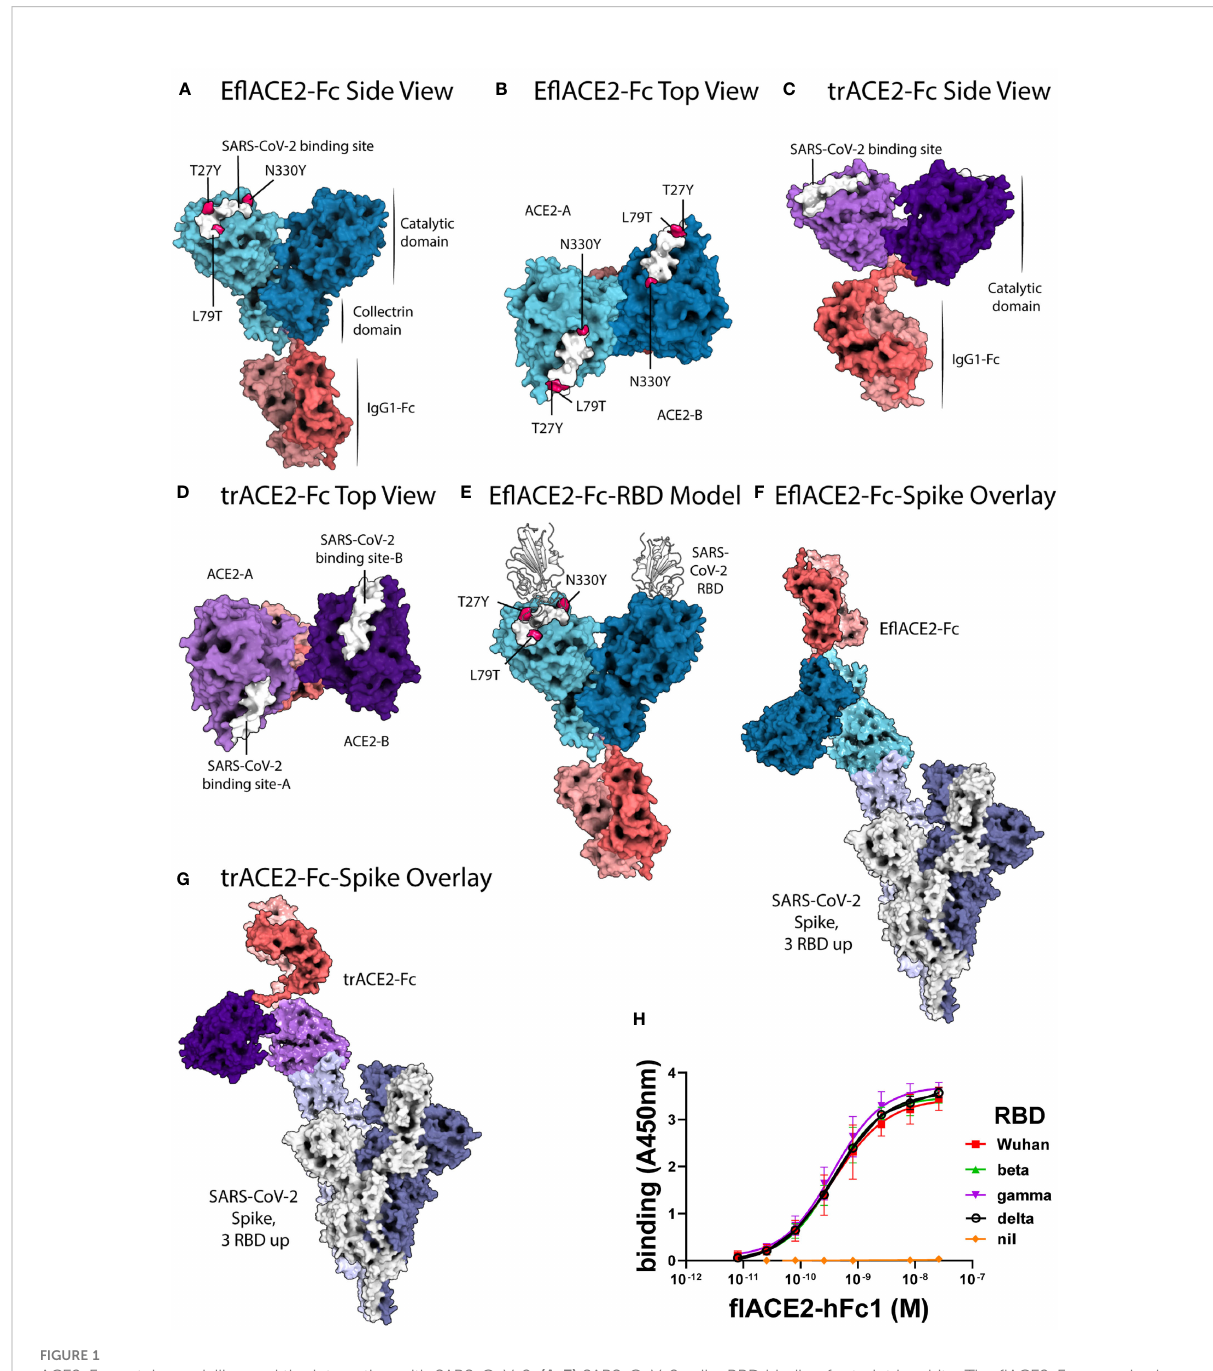
FIGURE 1 ACE2-Fc protein modelling and the interaction with SARS-CoV-2. (A-E) SARS-CoV-2 spike RBD binding footprint in white. The fl ACE2-Fc comprised a full-length ACE2 ectodomain (aa 19-740) fused to human IgG1-Fc. (A, B) E fl ACE2-Fc, having improved RBD binding is a variant of fl ACE2-Fc wherein three-point mutations, T27Y, L79T and N330Y, have been incorporated into ACE2 component (43) to enhance binding af fi nity to SARS-CoV-2 spike RBD. (C, D) The truncated ACE2 ectodomain (aa 19-615) was fused to human IgG1 Fc generating the trACE2-Fc fusion protein. (E) HADDOCK model of SARS-CoV-2 spike RBD binding to E fl ACE2 SARS-CoV-2 spike RBD shown in cartoon representation in white. (F) E fl ACE2-Fc shown overlayed on, and aligned by, ACE2 residues 19-614 of the 7VXM cryo-EM complex of SARS-CoV-2 spike and ACE2. (G) trACE2-Fc shown overlayed on, and aligned by, ACE2 residues 19-614 of the 7VXM cryo-EM complex of SARS-CoV-2 Spike and ACE2. In (F, G) , Positioning of the ACE2 dimer and Fc disul fi des respectively indicate the ACE2-Fc constructs are unlikely to bind multiple RBD on a single spike trimer. (H) ACE2-Fc binding to variant SARS-CoV-2 spike RBD. The fl ACE2-Fc-WT fusion protein binds to the ancestral Wuhan RBD, and the beta, gamma and delta VOC RBDs with equivalent EC 50 values. Plotted values are mean ± SD, n = 3, except for delta RBD n = 2. Agonist versus response curve fi tting EC 50 ranged from 0.31 to 0.40